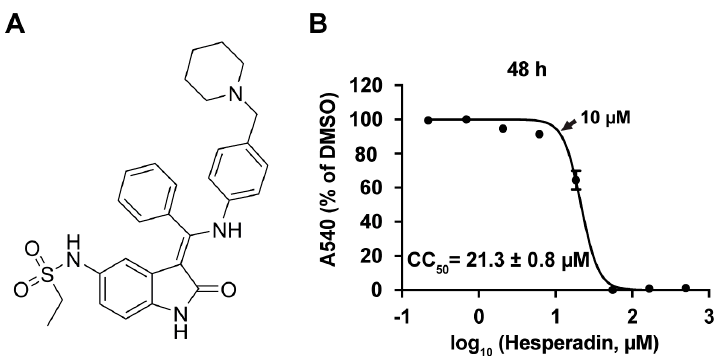
Figure 1. ( A ) Chemical structure of hesperadin; ( B ) Cytotoxicity of hesperadin. Serial concentrations of hesperadin were added to Madin-Darby Canine Kidney (MDCK) cells and incubated for 48 h. The cell viability was determined by neutral red up-taken assay [24]. The CC 50 was calculated from the best-fit dose response curves with variable slope in Prism 5. The arrow indicates the highest concentration used in Figure 2. The CC 50 value represents the average of eight repeats ± standard deviation.